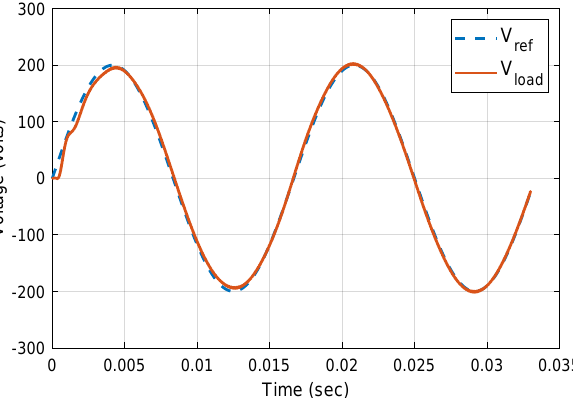
Figure 13. Time response of the sequentially-designed decentralized controllers for 200 (m) distance between the inverters.